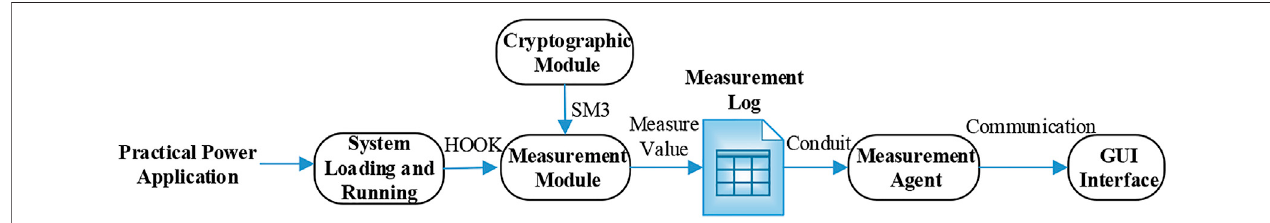
FIGURE 4 | Program running logic of the trusted computing program in the normal mode.